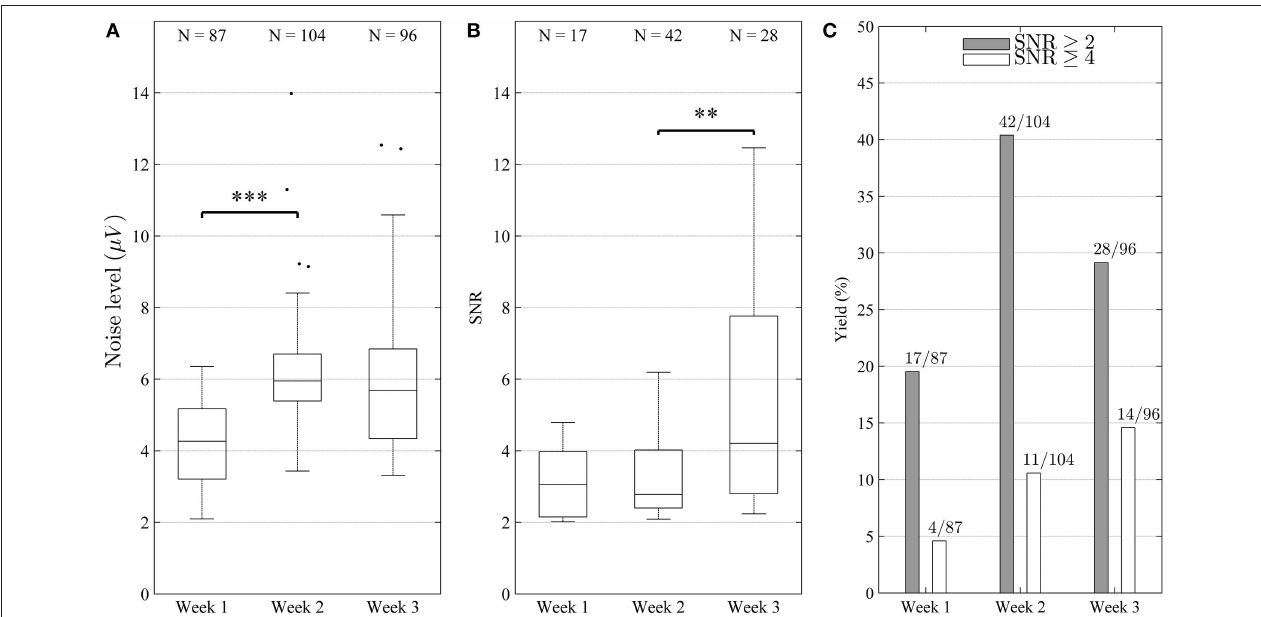
FIGURE 6 | Characterization of electrode performance over time. (A) Noise level estimated by Equation (1) (distributions shown as median and percentiles values) including all electrode channels. The noise increased significantly ( *** p < 0.001 ) between weeks 1 and 2, but remained stable between weeks 2 and 3 ( p > 0.05 ). (B) Signaltonoiseratio(SNR)ofsingle-units(distributionincludingallidentifiedunitsshownasmedianandpercentilevalues)remainedstable( p > 0.05 )betweenweek1and 2, but increased significantly between week 2 and 3 ( ** p < 0.01 ). This reflects the fact that high amplitude units were added during week 3. The increase in SNR and yield suggest that the overall recording conditions improved during the course of the experiment. (C) Bar diagram depicting yield in percentage (number of channels with units dividedbynumberofchannelsisshownontopofeachbar).Itcanbeseenthatyieldincreasedforbothgood(SNR ≥ 4)andfair(SNR ≥ 2)units (C) ,althoughtheincrease was not strictly monotonic for fair units (peaked during week